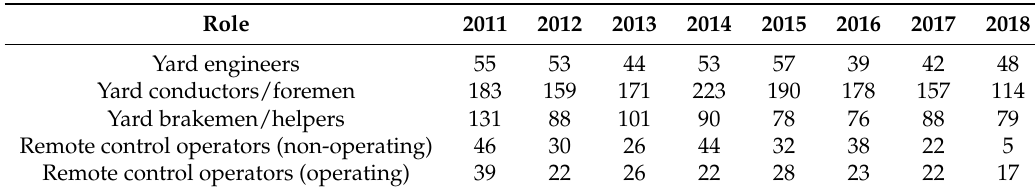
Table 1. Yard worker casualties from